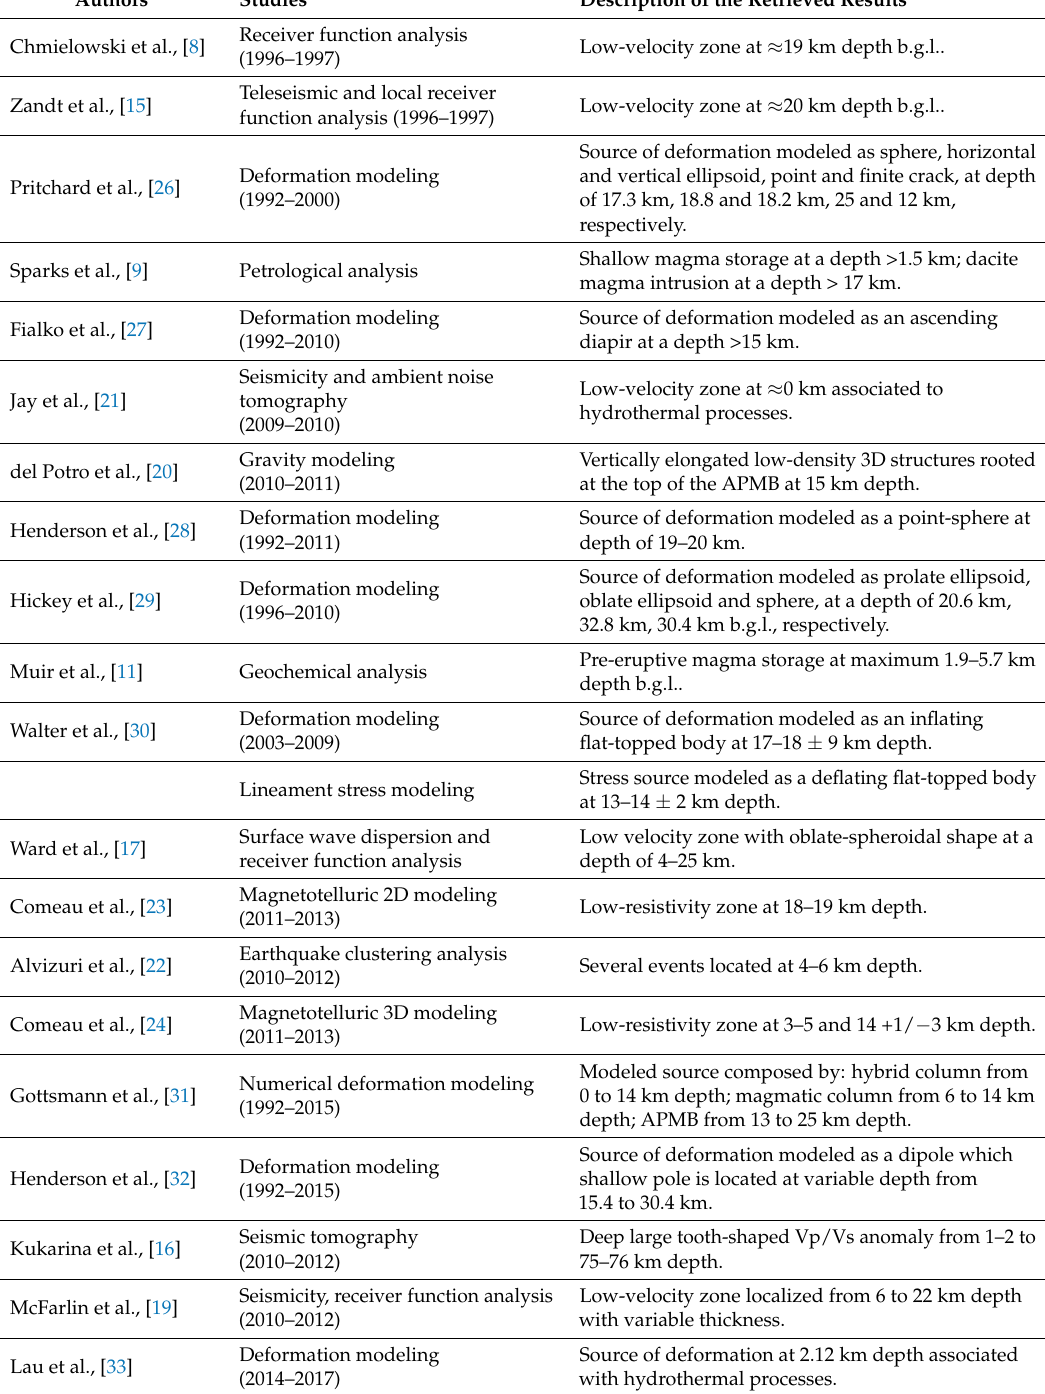
Table 1. Summary of previous works. Main results provided by previous studies for Uturuncu volcano and APMB. Where not specified, depths are referred to sea